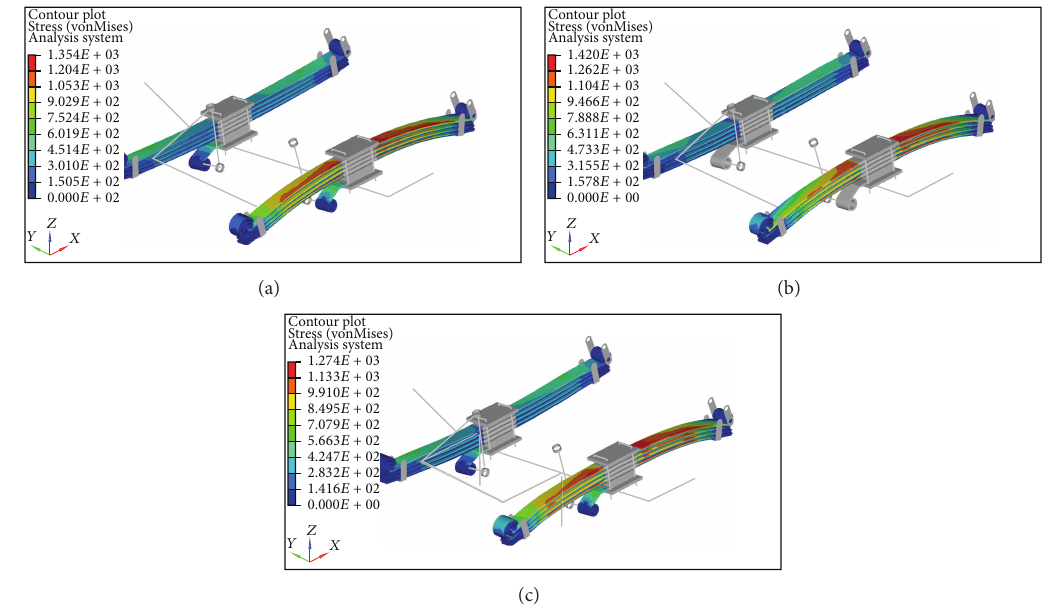
Figure 13: von Mises stress contour of parabolic leaf springs under roll load case: (a) Baseline model, (b) Iteration 1, and (c) Iteration 2.